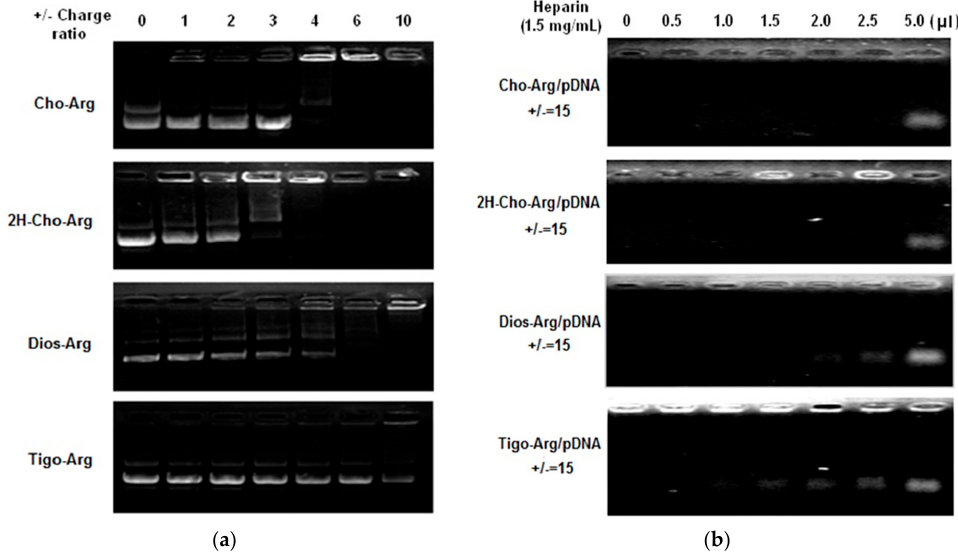
Figure 1. ( a ) Agarose-gel retardant assay of pDNA binding affinity for the steroid-based cationic lipids under various +/ − charge ratios. ( b ) Heparin competition assay of the stability of the under various +/ − charge ratios; ( b ) Heparin competition assay of the stability of the steroid-based steroid-based cationic lipids/pDNA lipoplexes (± = 15). cationic lipids/pDNA lipoplexes ( ± =